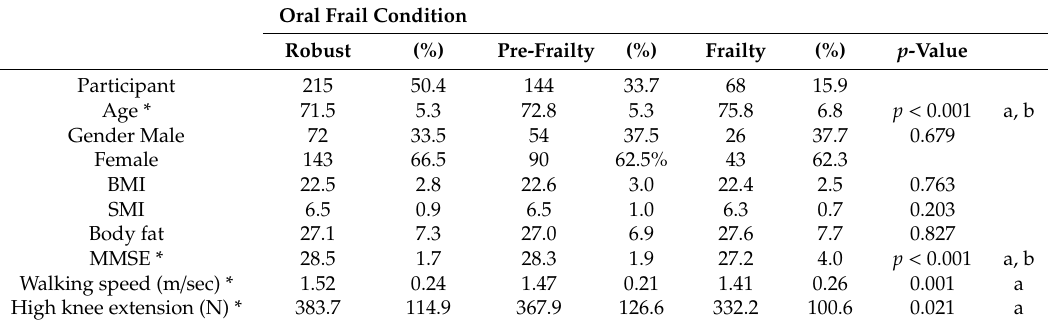
Table 3. Relationship between the oral condition and physical factors.